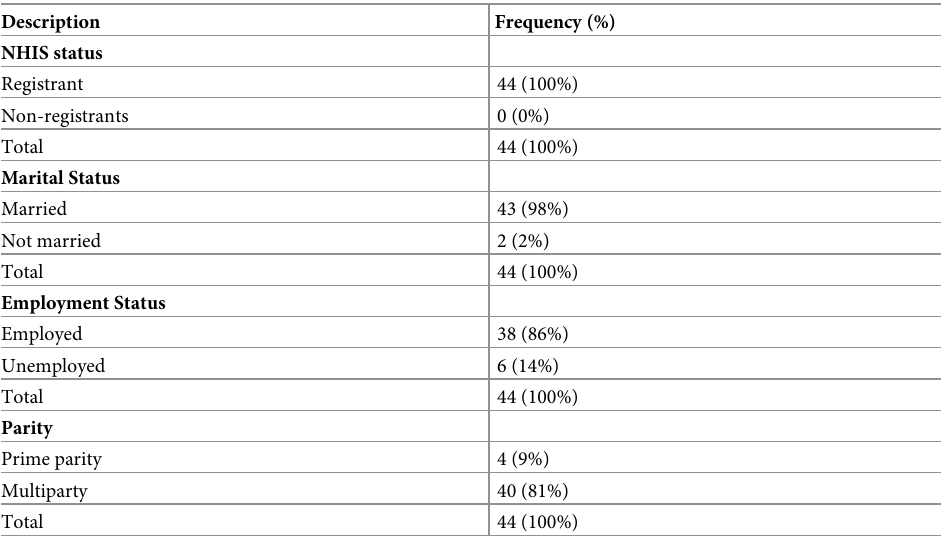
Table 8. Characteristics of pregnant women